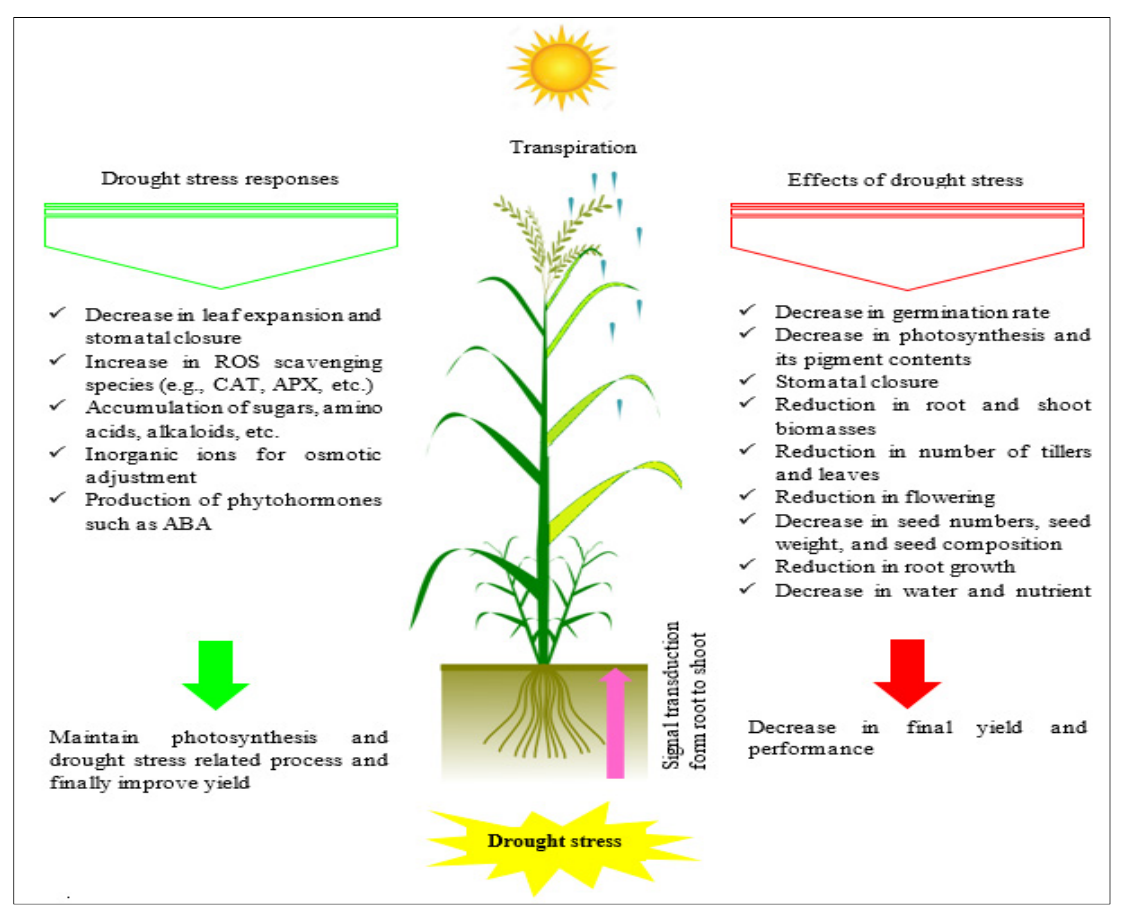
Figure 3. Schematic of the information flow of drought stress on various mechanisms of plant growth and developmental phases, and responses of plants to this environmental stress.